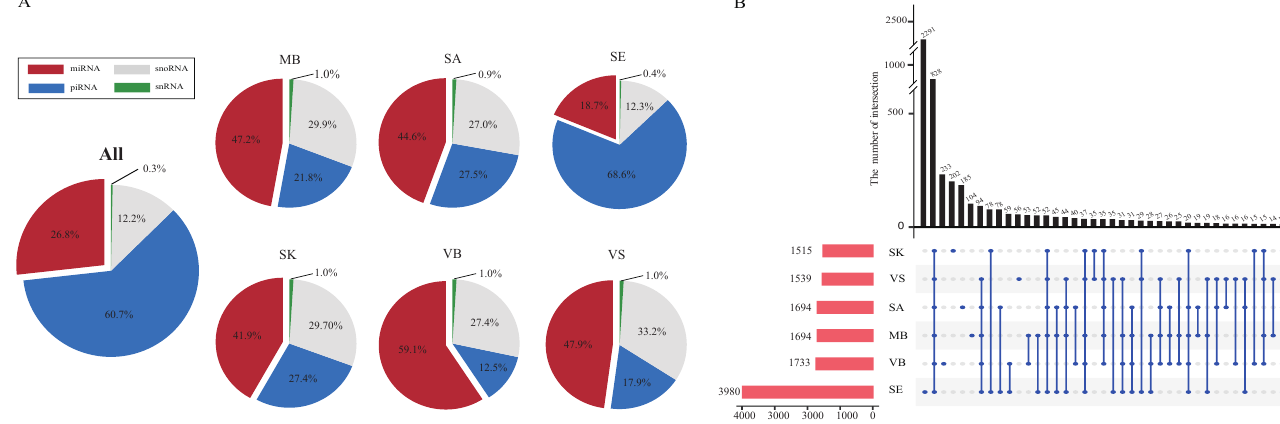
Figure 3. Quantity distribution of the small RNAs in six groups. ( A ) RNA class percentage in all groups; ( B ) intersection distribution of RNAs between different groups. MB = menstrual blood; SA = saliva; SE = semen; SK = skin; VB = venous blood; VS = vaginal